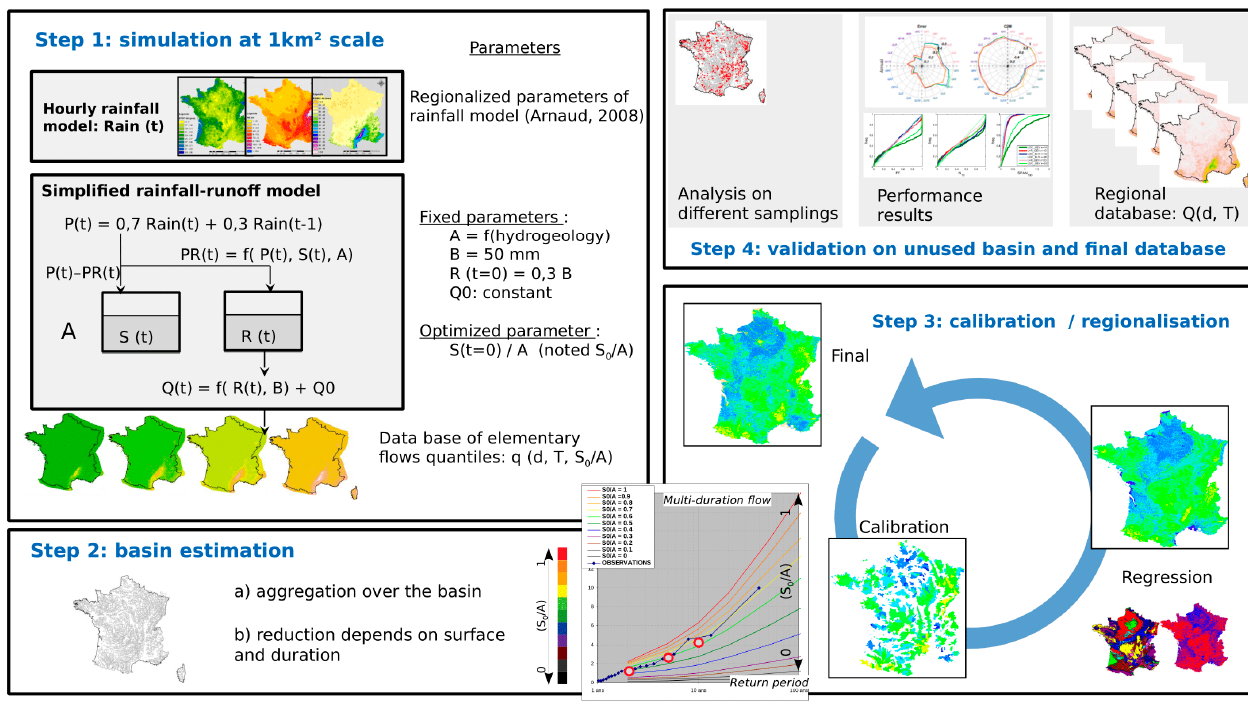
Figure 1. Steps associated with the implementation of the SHYREG method.